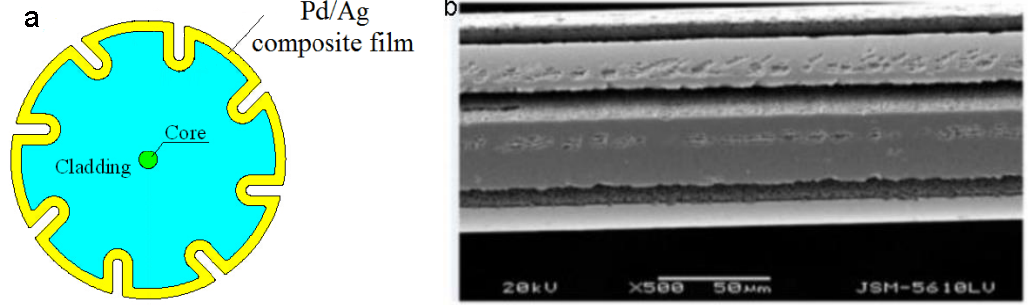
Figure 6. ( a ) Configuration of micro-machined FBG hydrogen sensor [34]; ( b ) SEM of micro-machined FBG coated with Pd/Ag composite film [34].